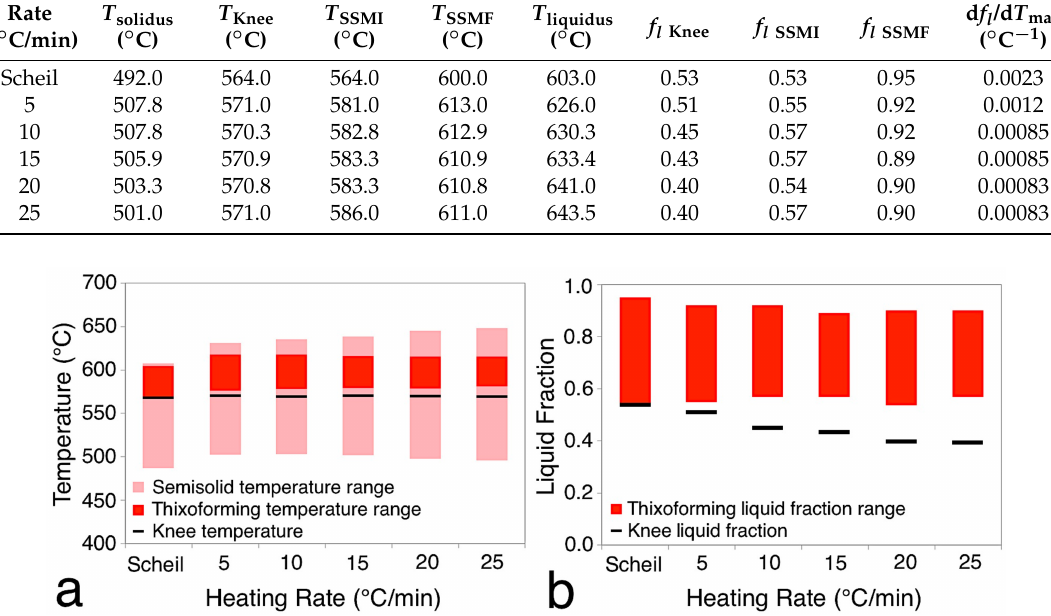
Figure 6. Key thixoforming parameters for B319+Fe alloy at different heating rates: temperature ( a ) and liquid fraction ( b ). The values predicted by numerical simulation are shown for reference (leftmost column in each